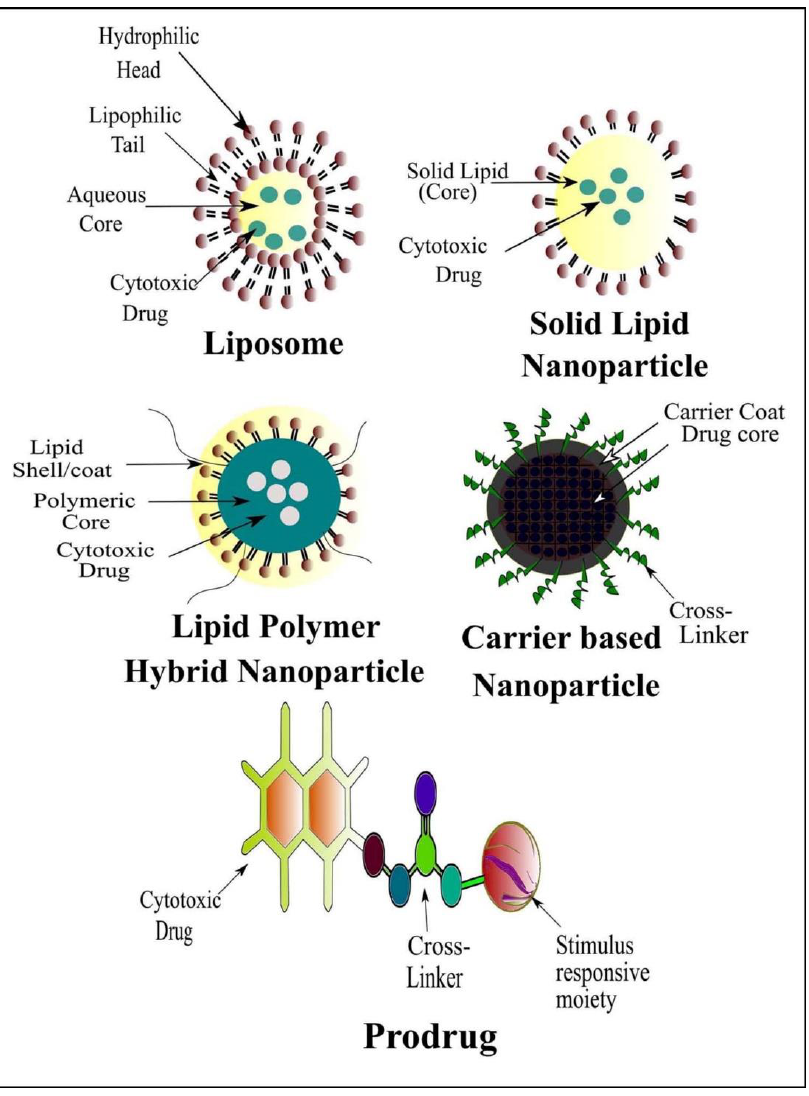
Figure 1. Renowned Stimuli-Responsive Drug Delivery Systems for Cancer Chemotherapy .